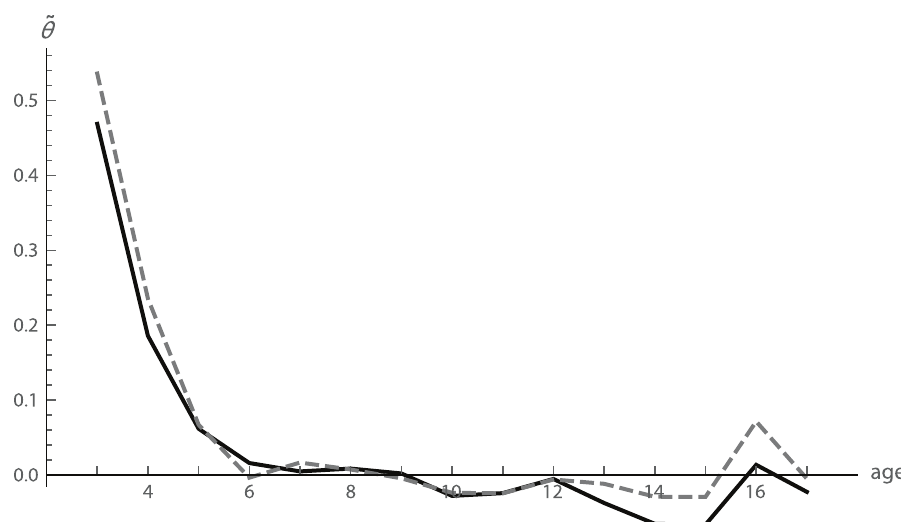
, for cranial size before t